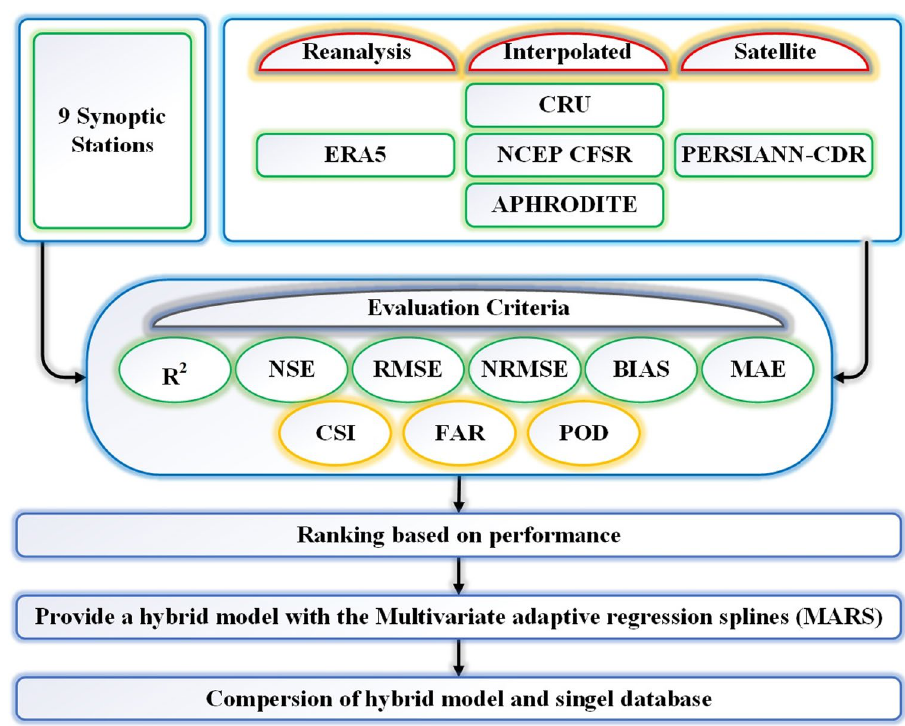
Fig. 2 The flowchart of research methodology